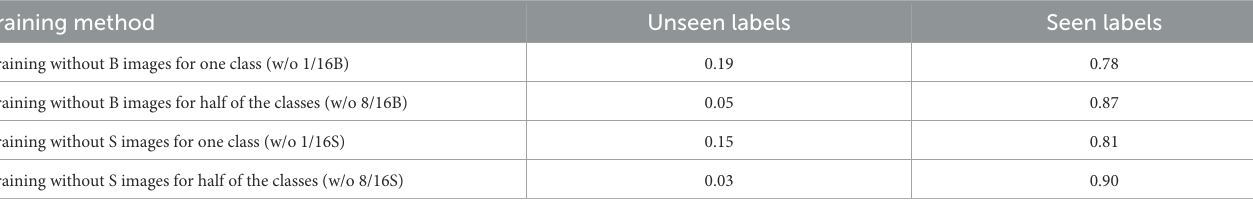
TABLE 2 The results of zero-short learning test.